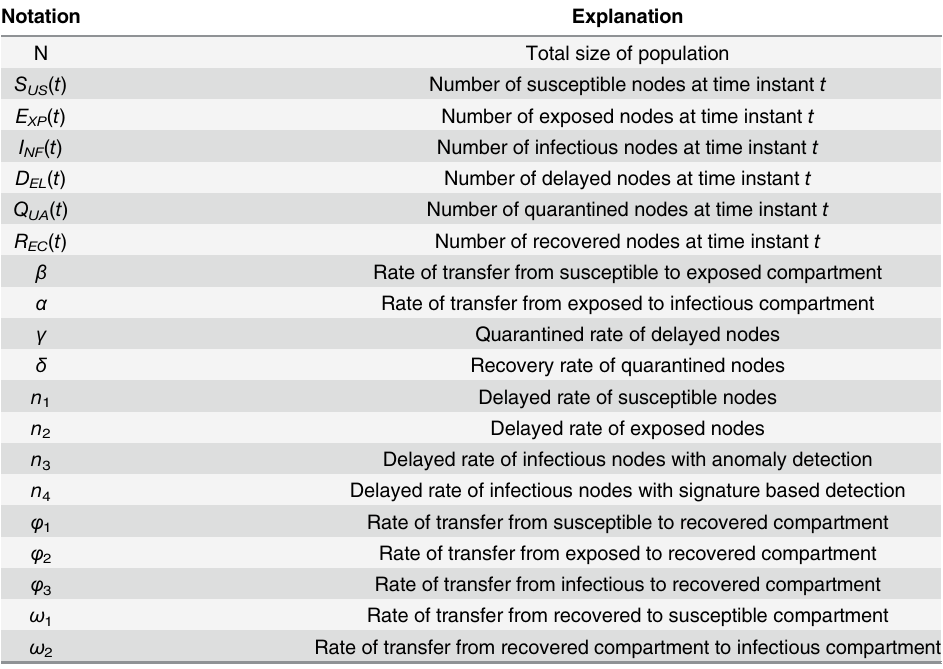
Table 1. Notations and